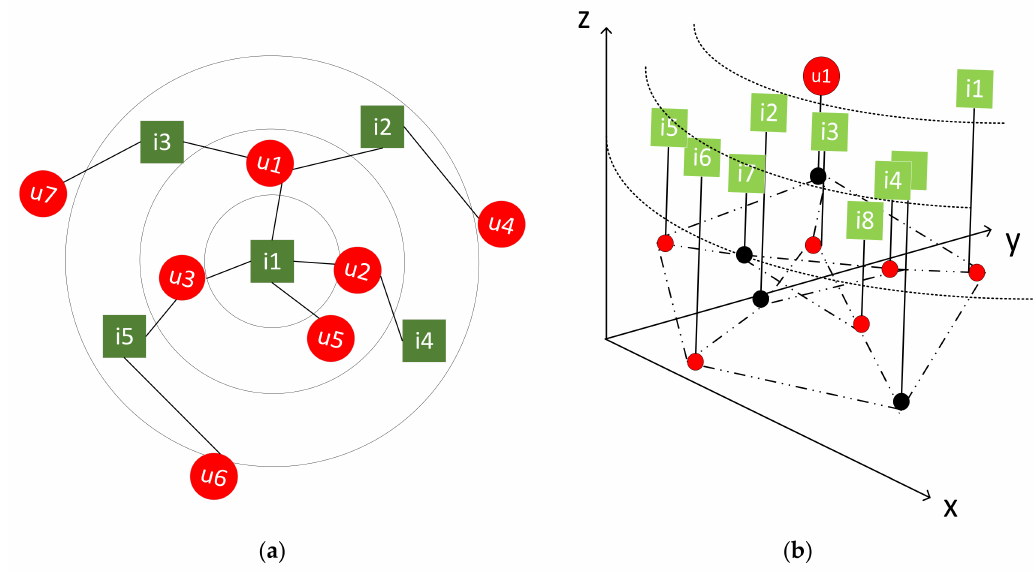
Figure 1. This is a user–project interaction diagram: ( a ) user–project space interaction diagram; ( b ) user–project spectrum domain interaction